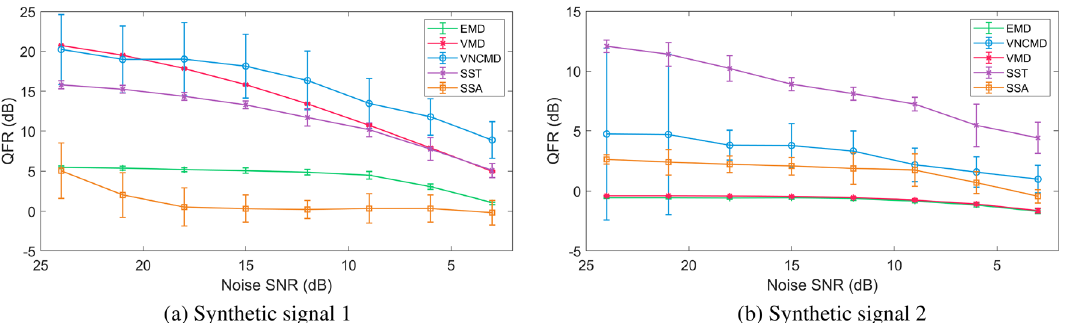
Figure 5. QRF versus SNR for synthetic signal 1 ( a ) and synthetic signal 2 ( b ), averaged over 50 different iterations of Gaussian white noise. The standard deviation is plotted as error bars for each